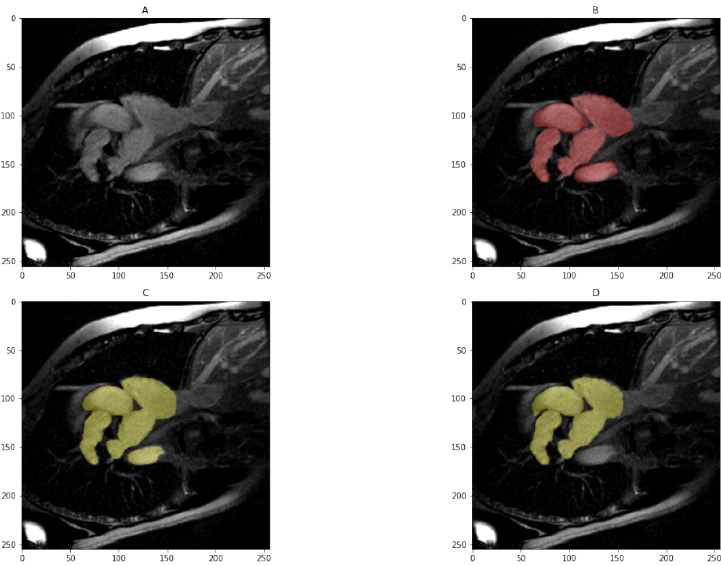
Figure 2. Sample results from the imATFIB validation set (Red—ground truth, Yellow—model prediction). ( A ) Input image, ( B ) Label mask, ( C ) All Ensemble model ( M 9 ), ( D ) U-net model ( M 4 ).